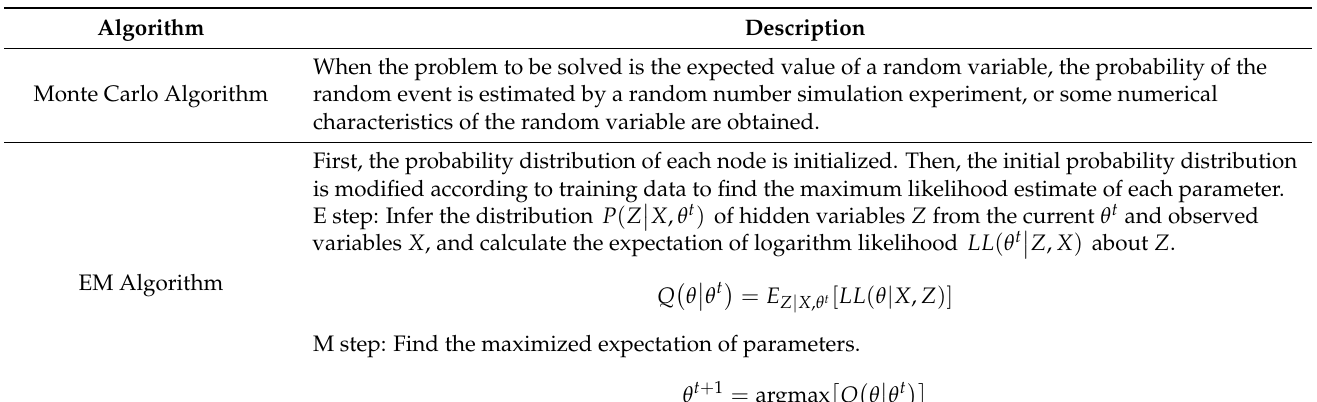
Table 9. Monte Carlo algorithm and EM algorithm.